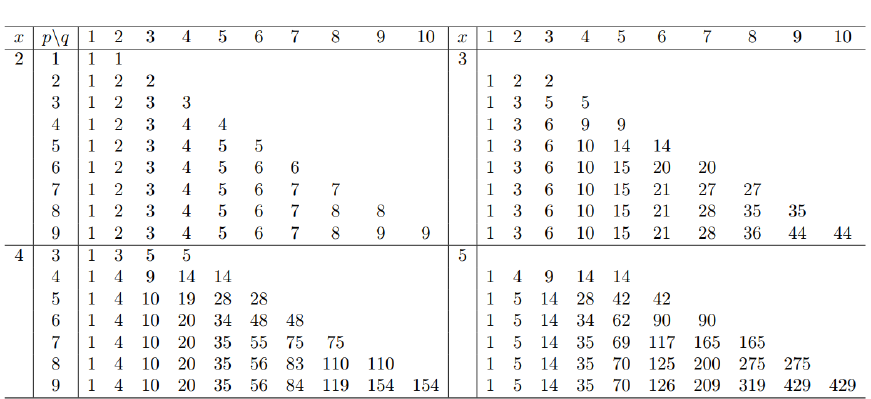
Figure 6. Numbers h p